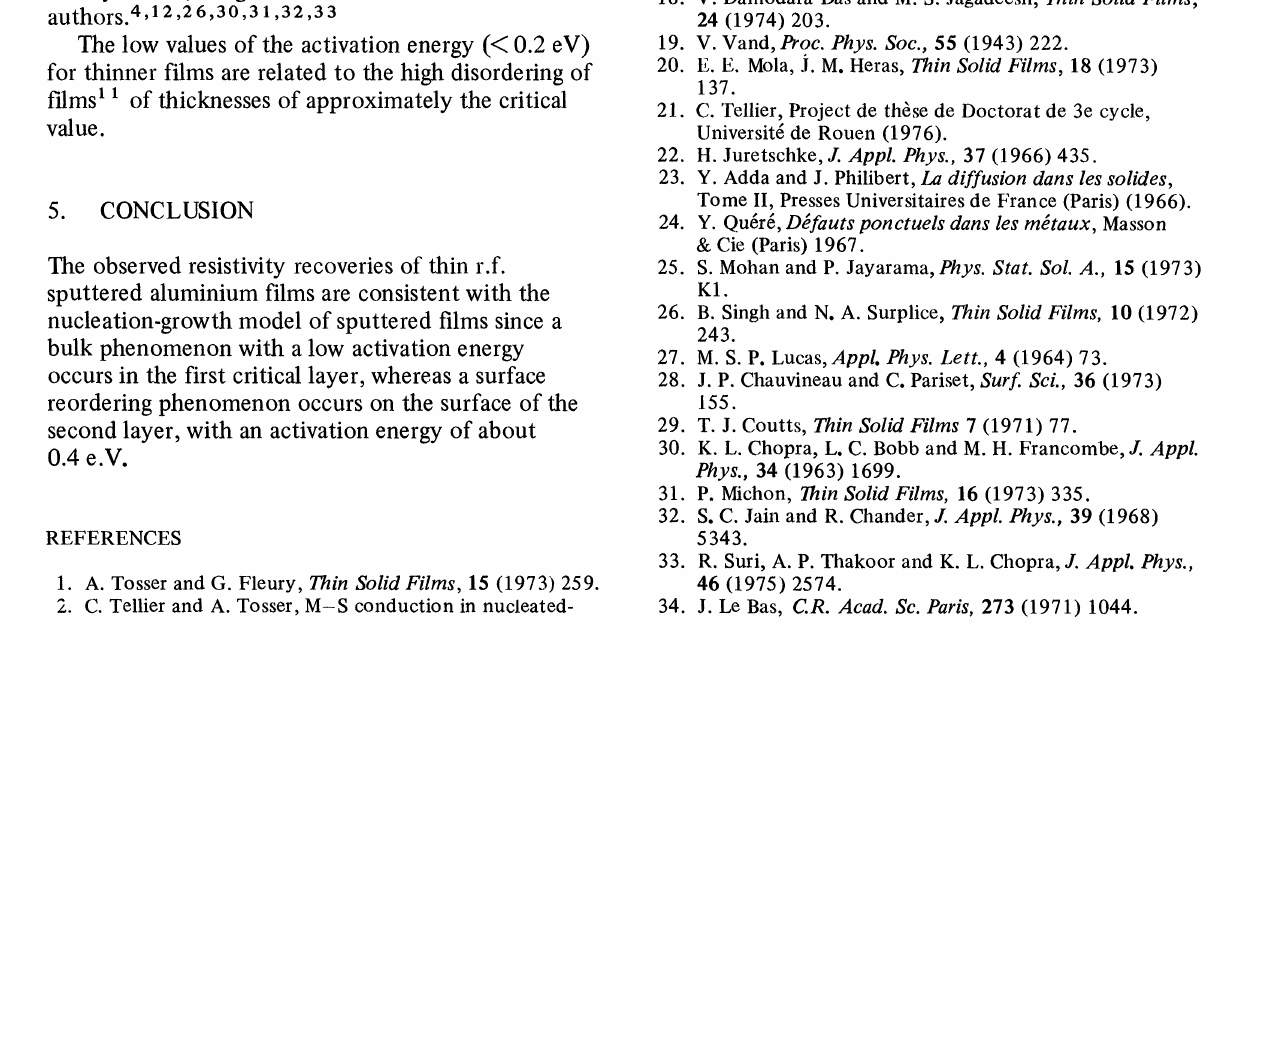
FIGURE 6 Variations of the ratio Rs/R o of the resistance R and R o of annealed and un-annealed films with R